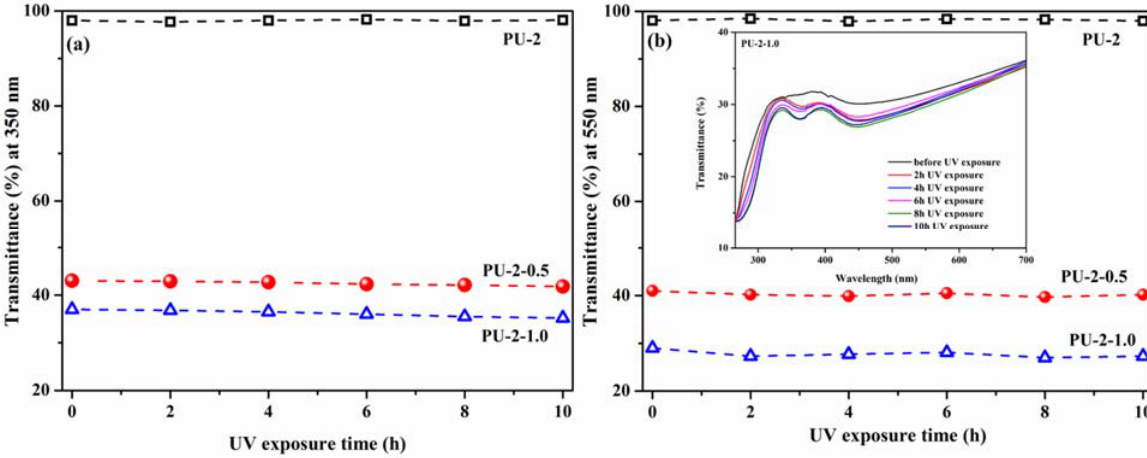
Figure 11. Transmittance values at 350 nm ( a ) and 550 nm ( b ) of PU-2, PU-2-0.5 and PU-2-1.0 films after different UV exposure time intervals. The inset is the transmittance spectra of PU-2-1.0 after different UV exposure time intervals (2, 4, 6, 8 and 10 h).